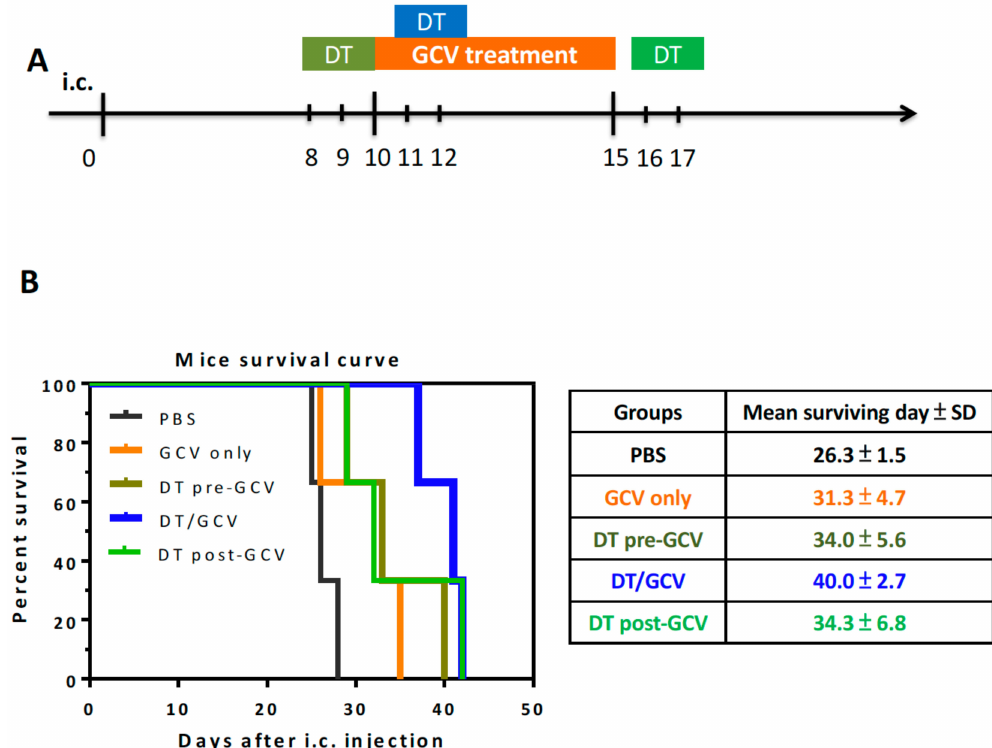
Figure 6. The time-dependent e ff ect of myeloid cell depletion. ( A ) The timeline of DT treatment and tk / GCV therapy in ALTS1C1-tk bearing CD11b-DTR mice. GCV was given twice a day from day 10 to day 15. DT / Pre-GCV: DT was given once a day at days 8 and 9. DT / GCV: DT was given once a day at days 11 and 12. DT / Post-GCV: DT was given once a day at days 16 and 17. ( B ) Kaplan–Meier survival curves of ALTS1C1-tk tumor-bearing mice receiving GCV combined with di ff erent DT administration timeline (Each group mice n =